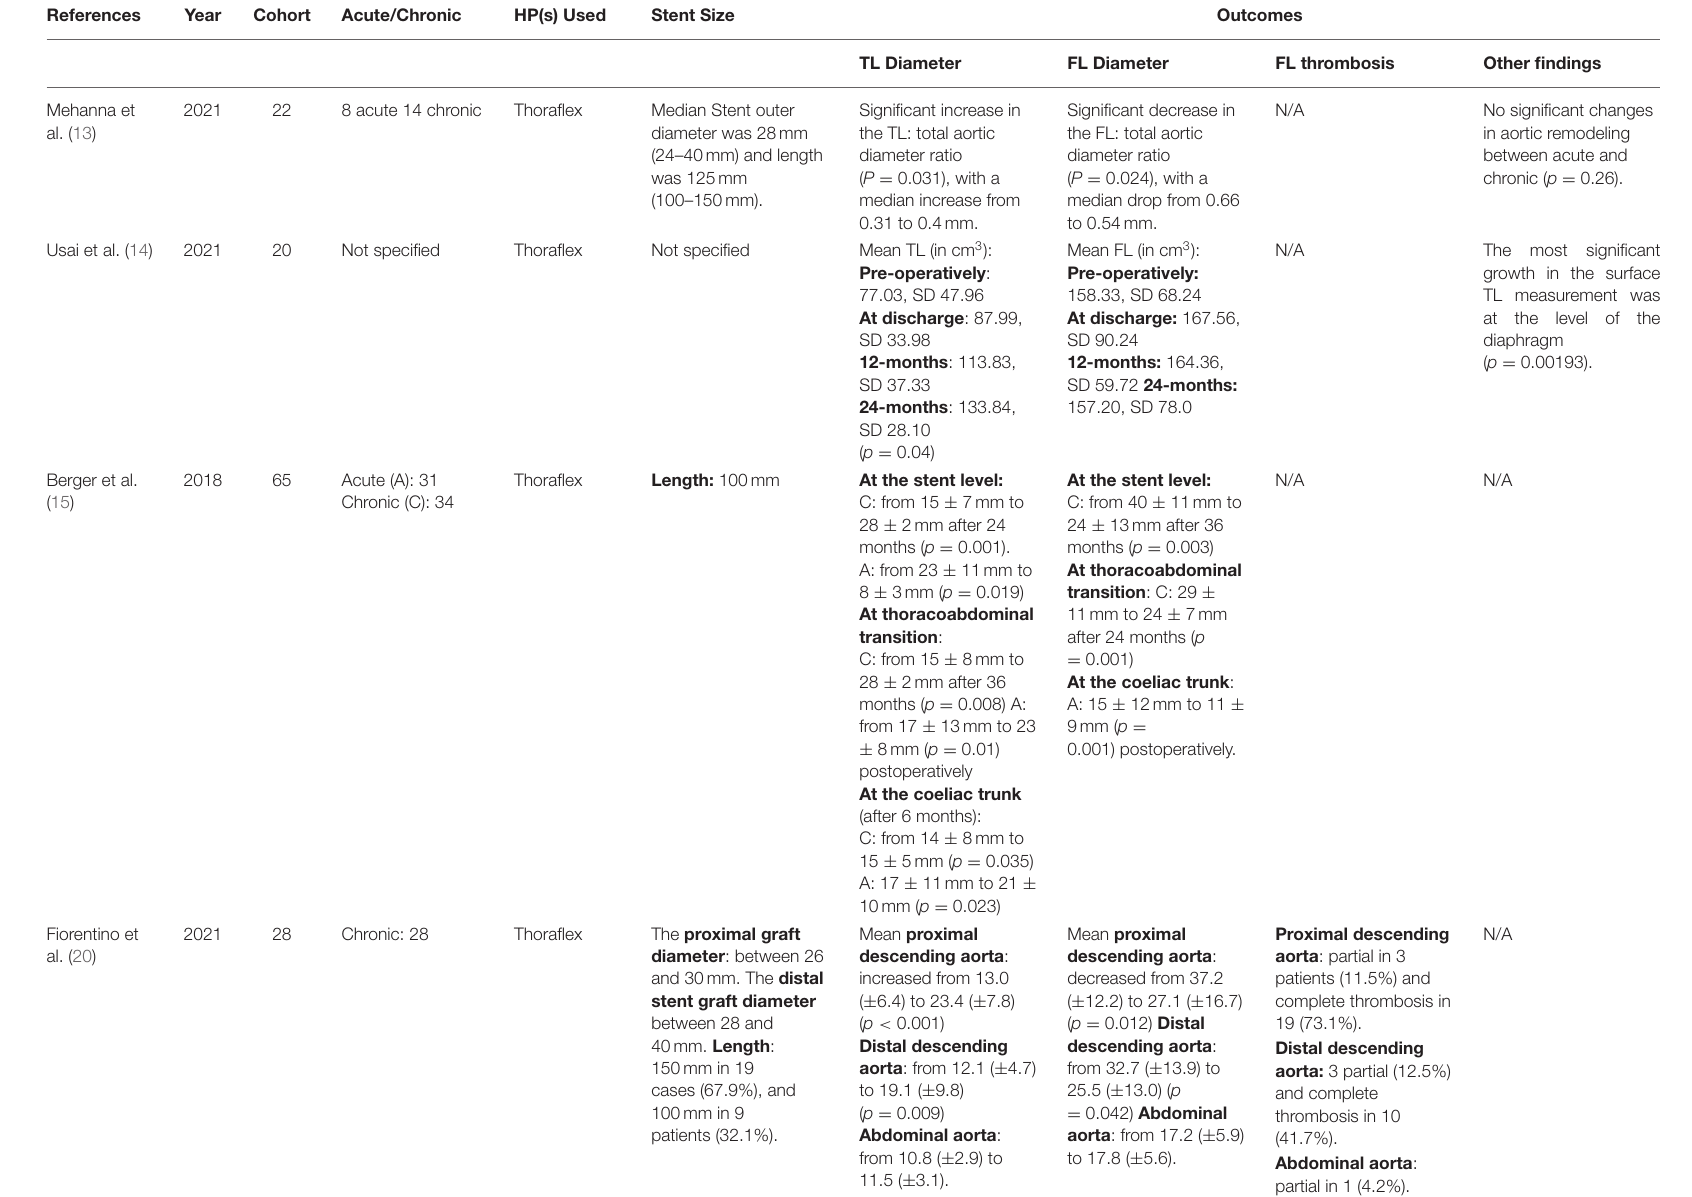
TABLE 4 | Summary of studies included in Distal Stent Induced New Entry and their aortic remodeling data